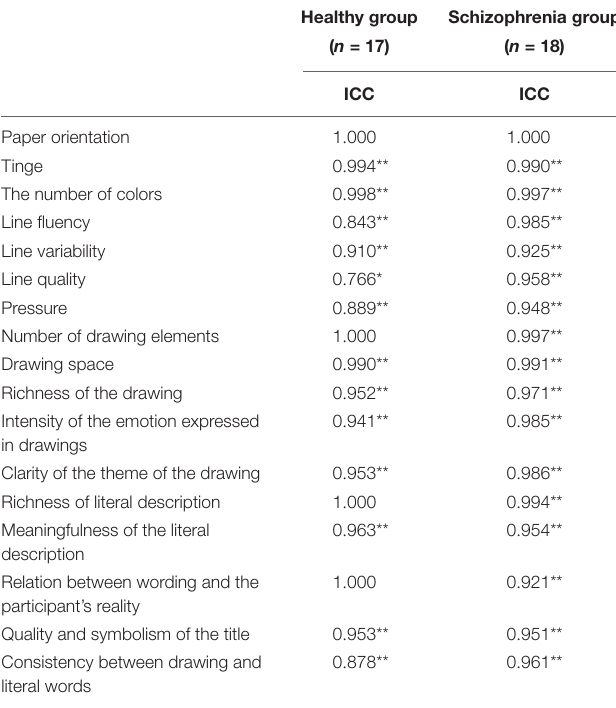
TABLE 3 | Consistency of ratings for drawing coding